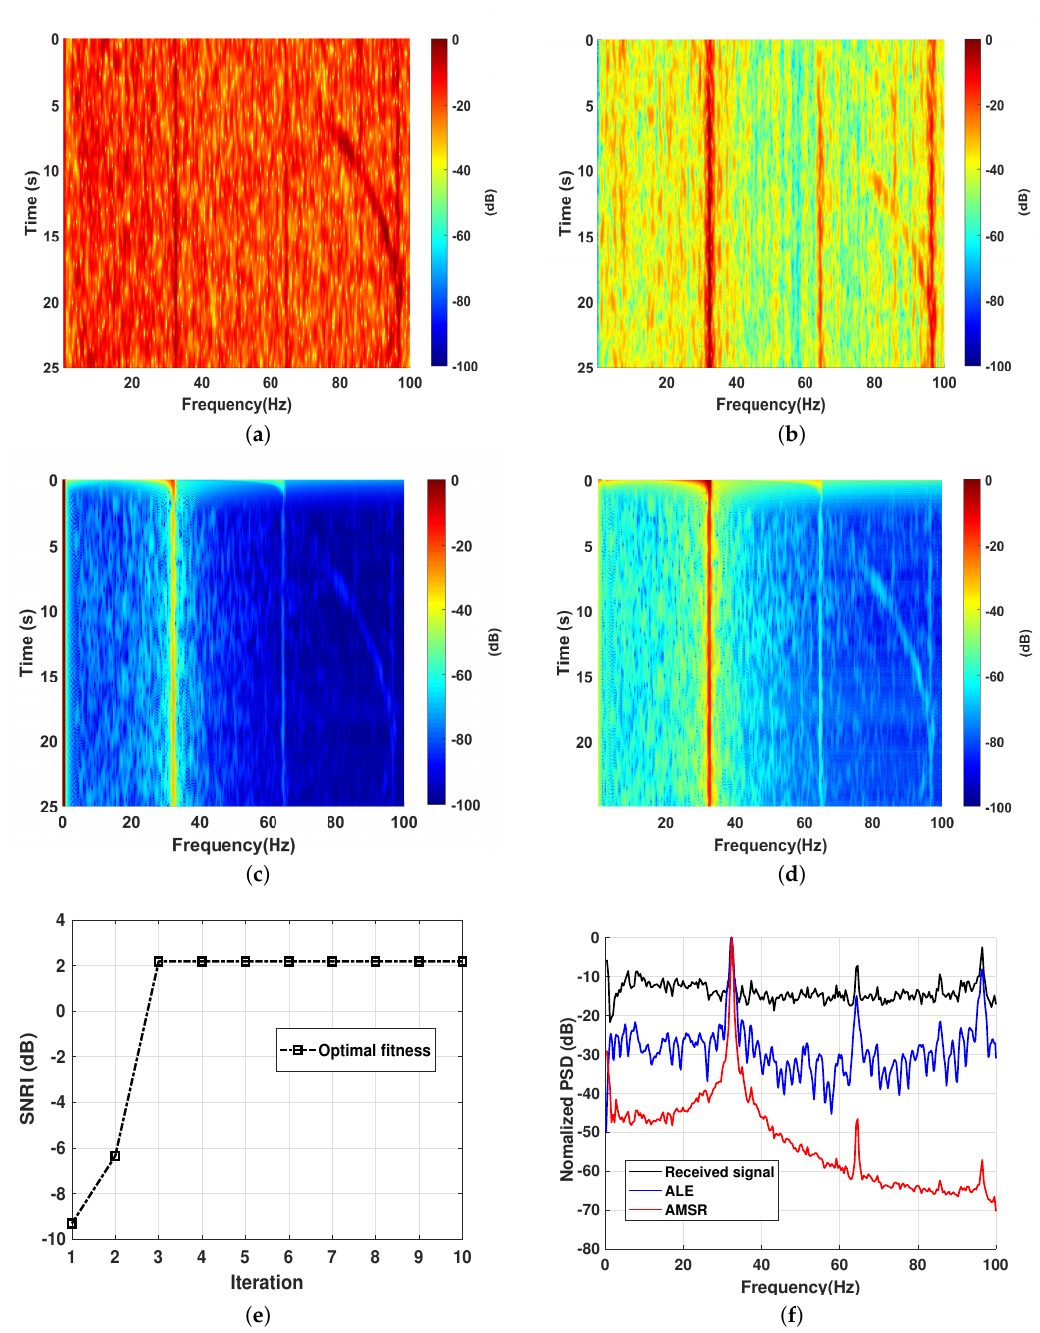
Filtering performance verification: ( a ) lofagram of the original received signal of an autonomous underwater vehicle (AUV); ( b ) lofagram of the adaptive line enhancer (ALE)output (LMS); ( c ) lofagram of the AMSR output ( γ opt = 0.1227, K opt = 85.6350, h opt = 0.4707); ( d ) lofagram of the AMSR output with direct current (DC) offset filter; ( e ) the optimal fitness at each iteration with GA; ( f ) normalized power spectrum denisty (PSD)